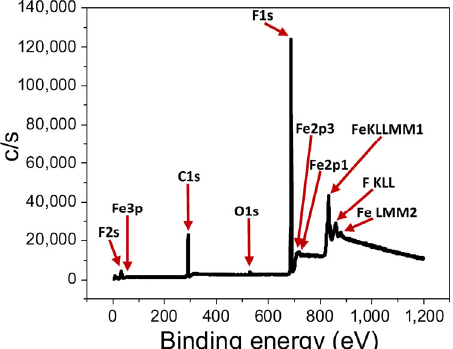
Fig. 9 XPS analysis of elements inside the wear track after durability test failure on sample P(12, 15).